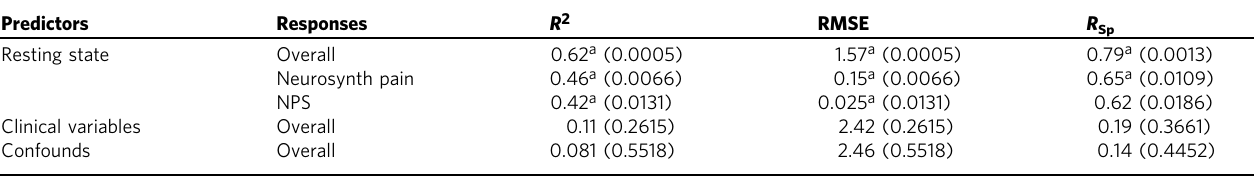
Each row contains results for a speci fi c set of predictors and responses. Each results column contains a prediction performance metric. R 2 coef fi cient of determination (sums-of-squares formulation), RMSE root mean squared error, R Sp Spearman ’ s rank correlation coef fi cient.